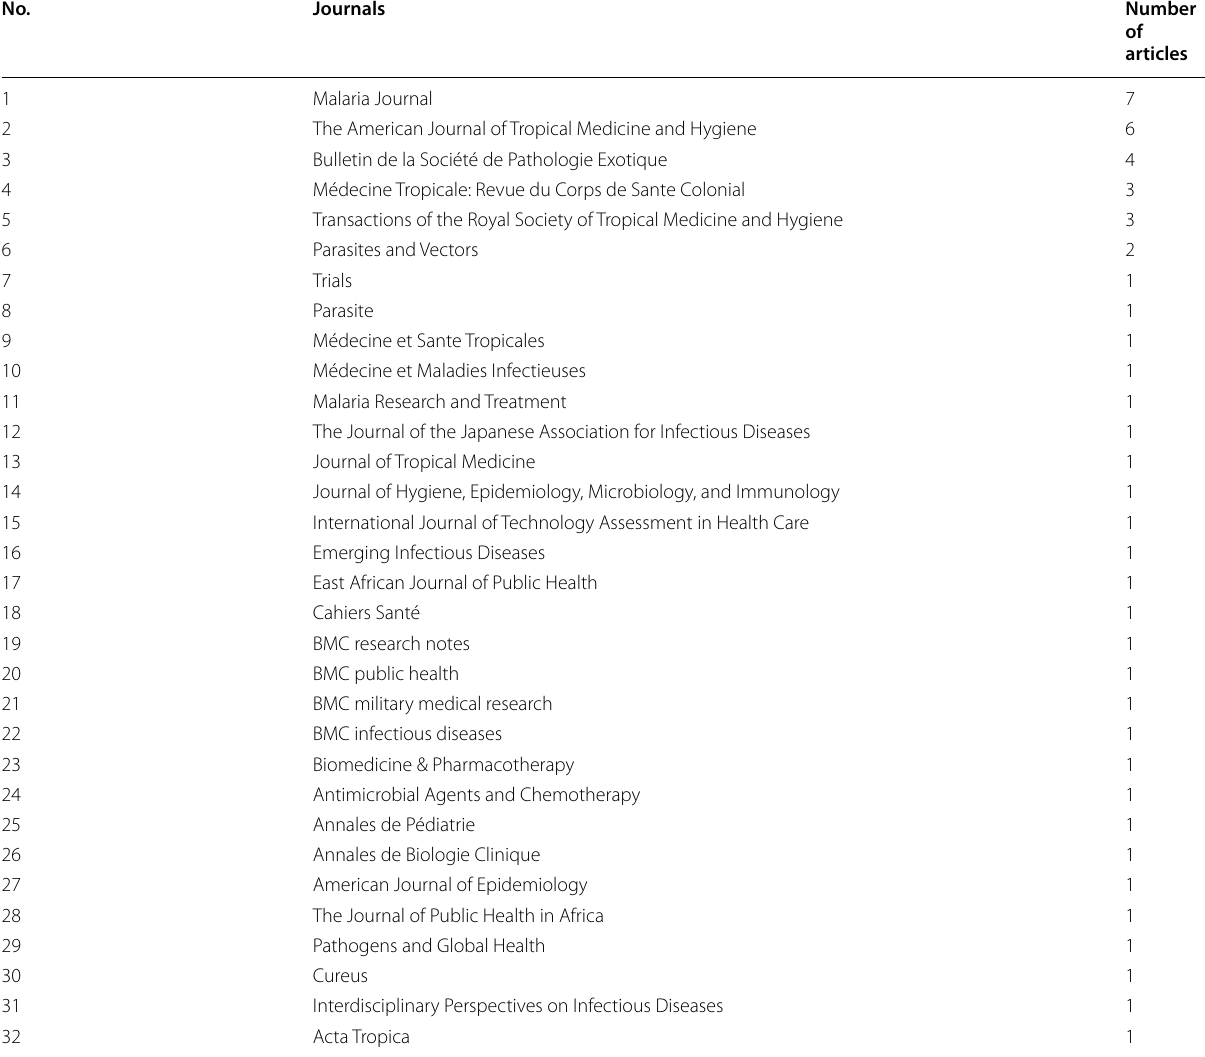
Table 1 Journals publishing malaria research from Central African Republic